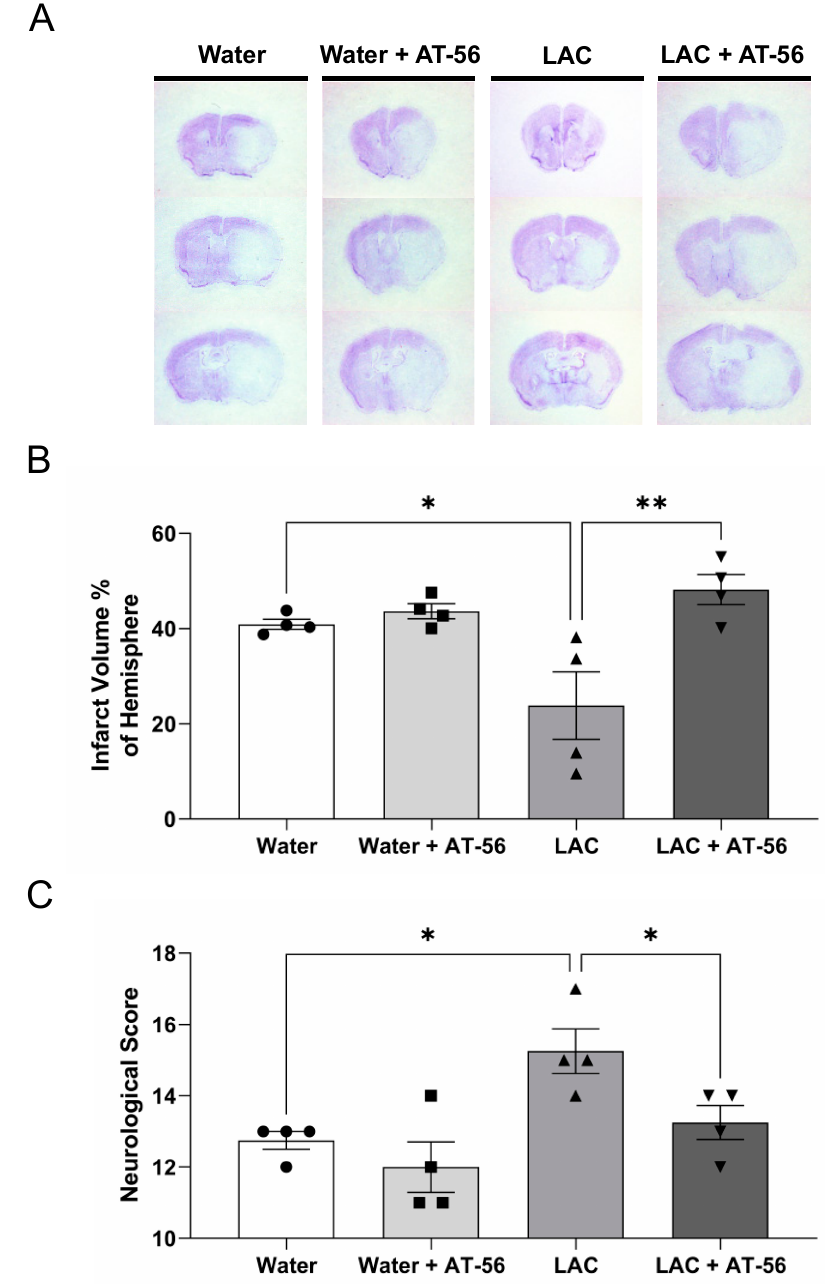
Figure 2. Effect of AT-56 on cerebral I/R injury. ( A ) Representative brain sections stained with cresyl violet. ( B ) Total infarct volume. ( C ) Neurological deficit score. Values are means ± SEM for 4 mice in each group. * p < 0.05. ** p < 0.005. Analyzed using two-way ANOVA followed by Tukey’s test.